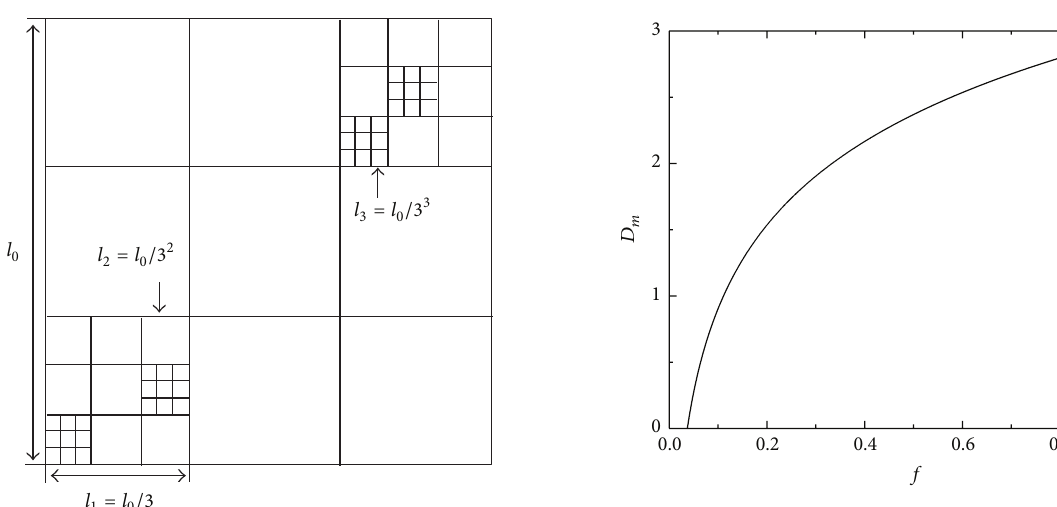
Figure 2: Dependence of the fractal dimension 𝐷 𝑚 of the probabil- ity 𝑓 from